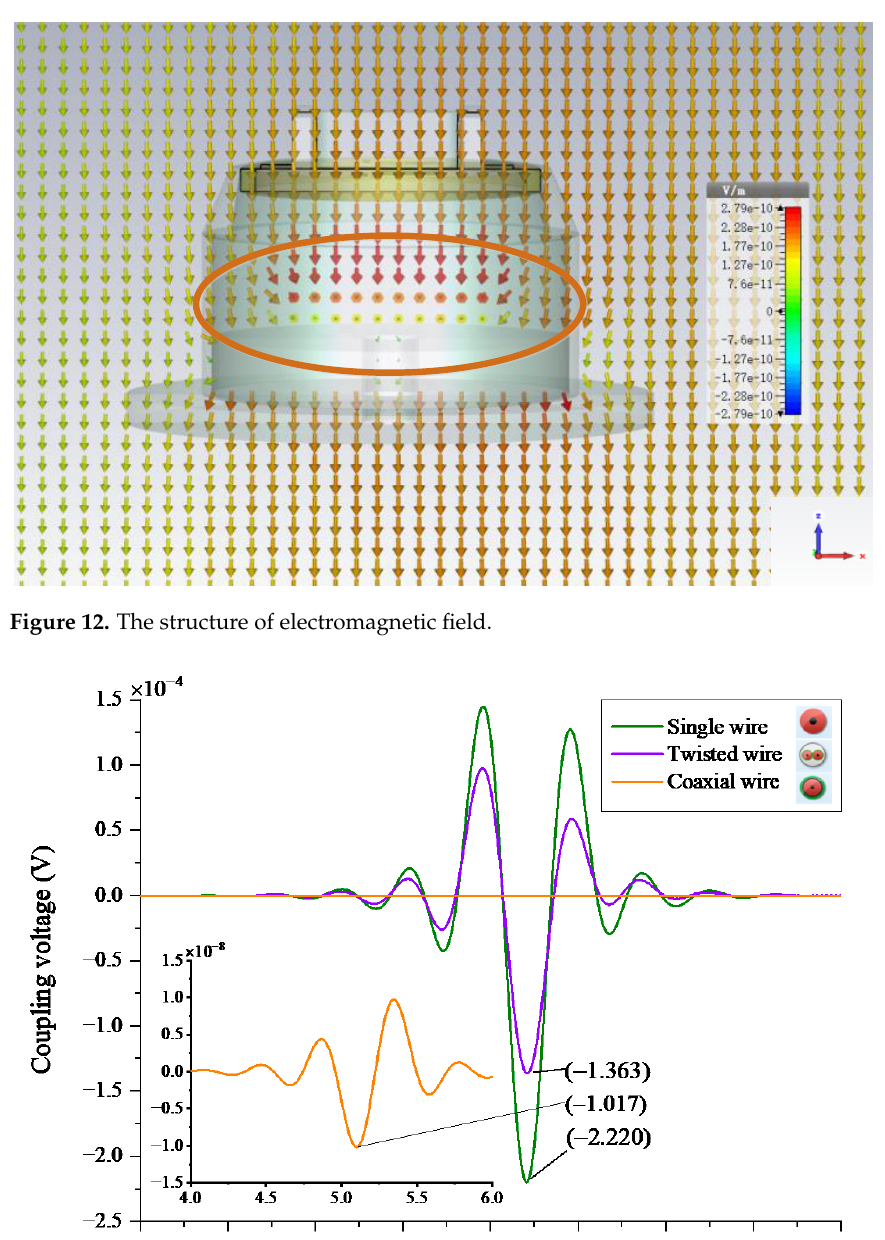
Figure 13. The responses of different categories of metal wire.